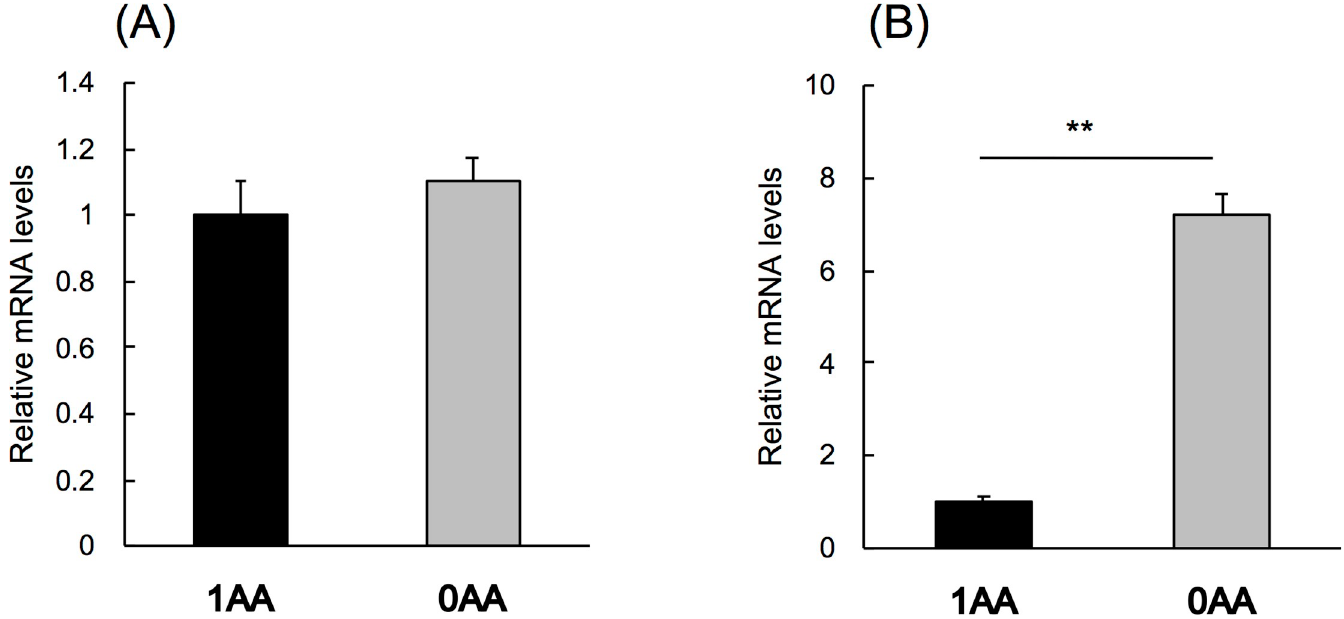
Fig 4. Effect of amino acid deprivation on Ob-R mRNA in H4IIE cells. H4IIE cells were cultured in media with amino acids (1AA) or without amino acids (0AA) for 6 h. Ob-R mRNA and CHOP mRNA were measured by real-time PCR. Results were expressed relative to those of 1AA, means ± standard errors (n = 5 or 6). Statistical difference between the group are shown as �� , P <